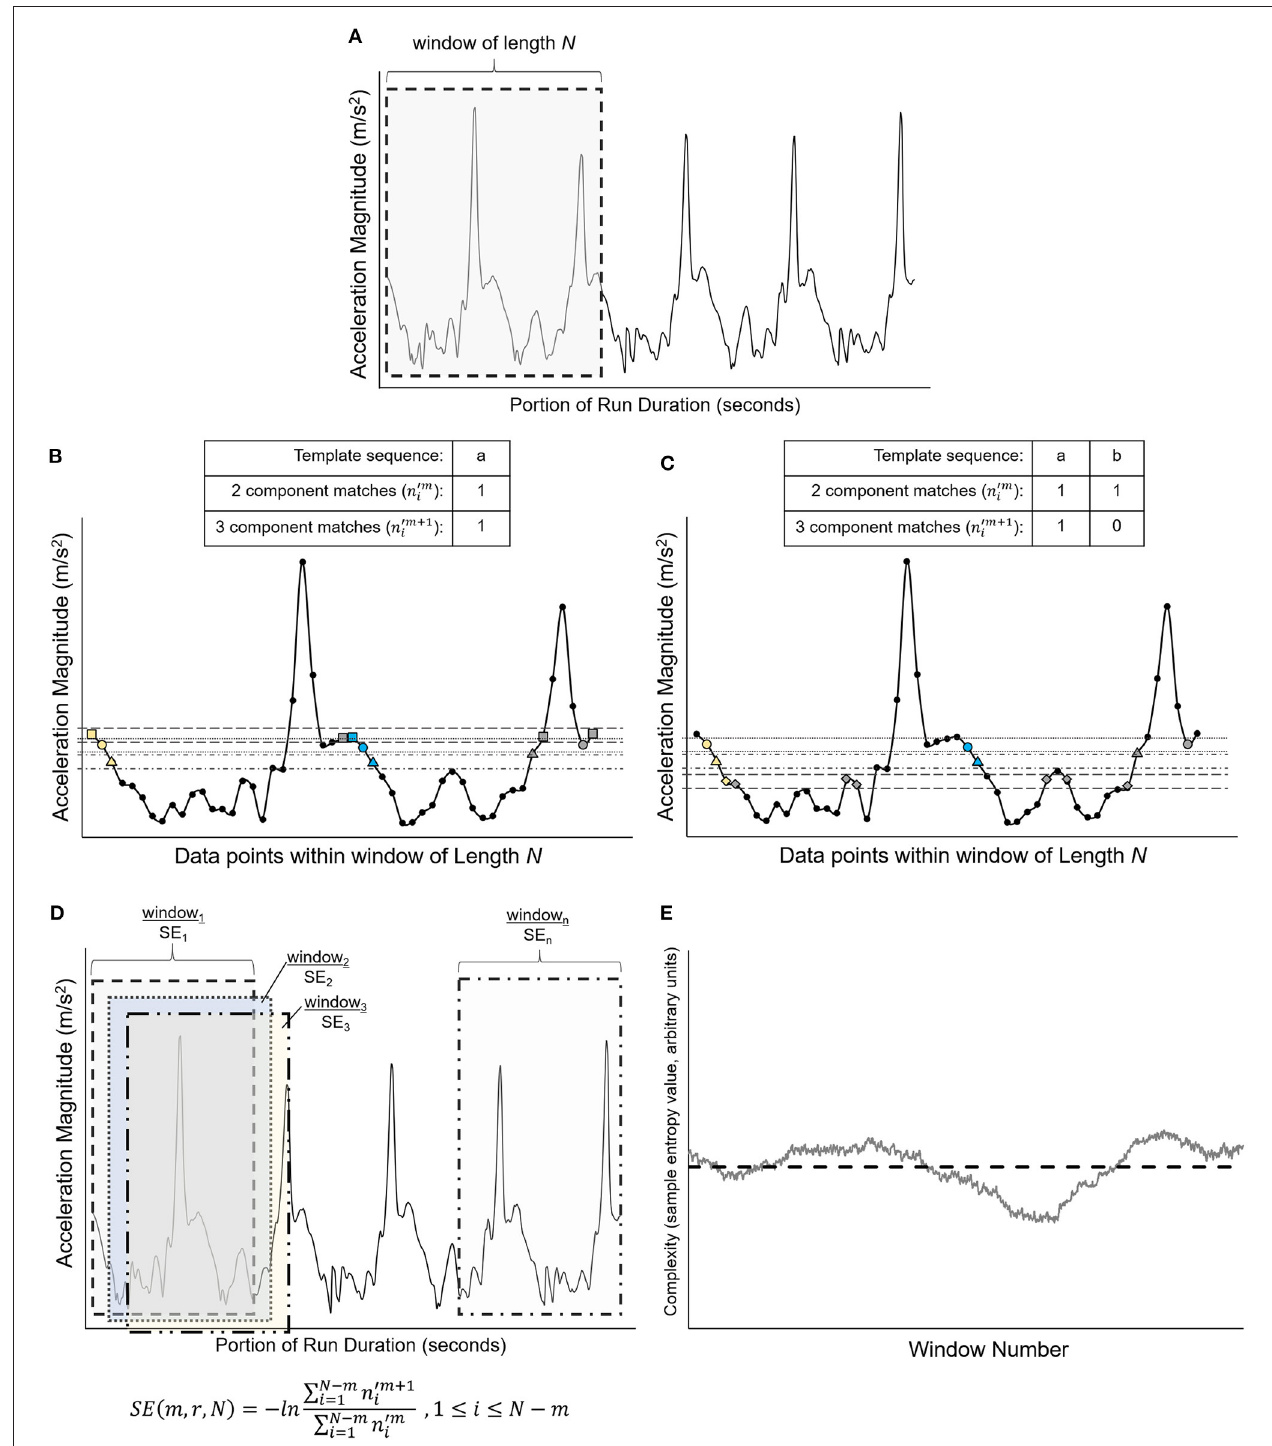
FIGURE 2 | Graphical representation of the vector matching procedure and sample entropy calculation [adapted from Costa et al. (2005)]. (A) Shows a portion of a simulated time series extracted from a simulated time series, with data points x 1 , …, x N . The first overlapping window of length N is represented by the gray-shaded region and is isolated in (B) . (B) Shows the first template sequence ( (cid:3) , ◦ , 1 ), which consists of data points x 1 , x 2 , and x 3 and is represented by the yellow symbols. The horizontal dashed lines represent the similarity threshold r around each data point of the template sequence. Two data points will match if the absolute difference between them is ≤ r . Blue-filled symbols are data points that fall within the similarity threshold r and match the sequence of data points for m and m + 1 vector lengths